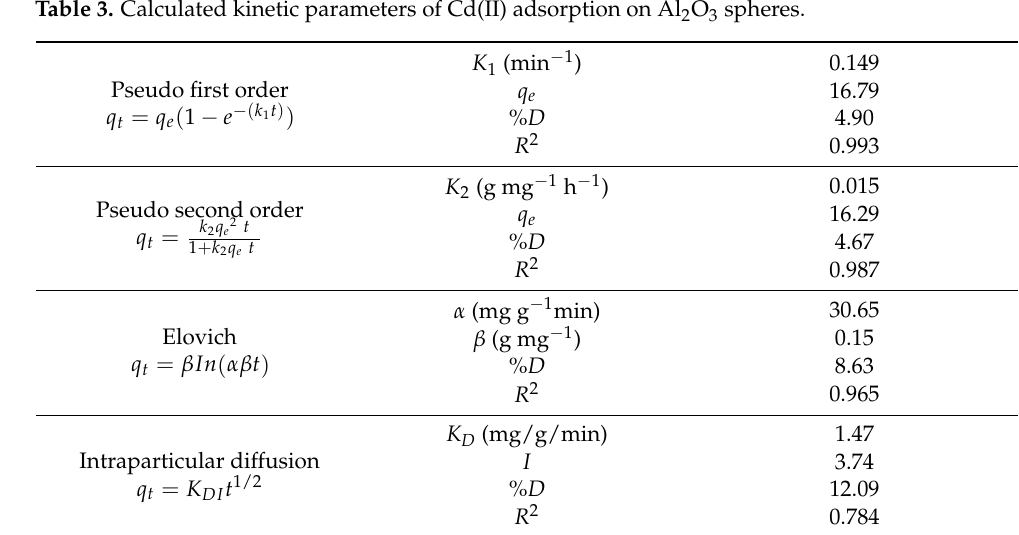
Table 4. Cd(II) adsorption isotherm parameters on alumina spheres at 1600 °C.